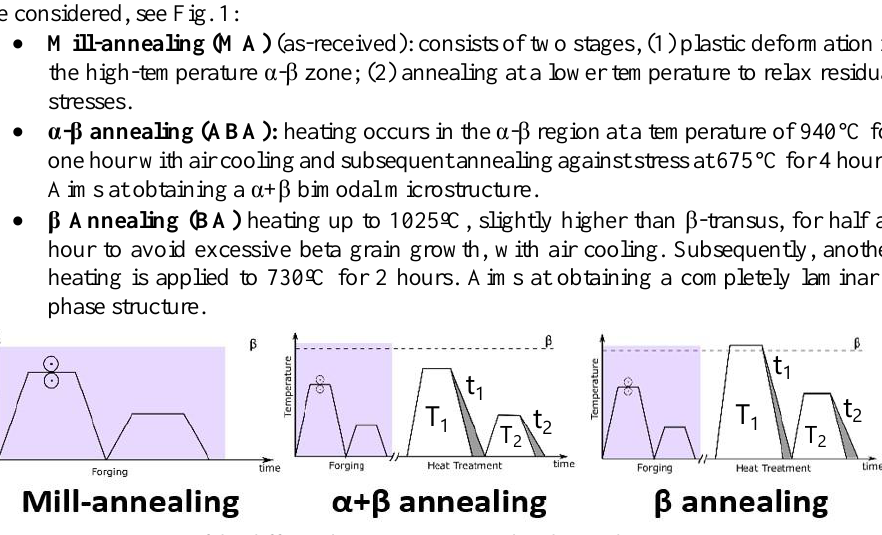
Figure 1: Diagram of the different heat-treatments used in this study. Details of times and temperatures of the HTs are shown in Table 2. Table 2: Details of the heat treatment considered in this